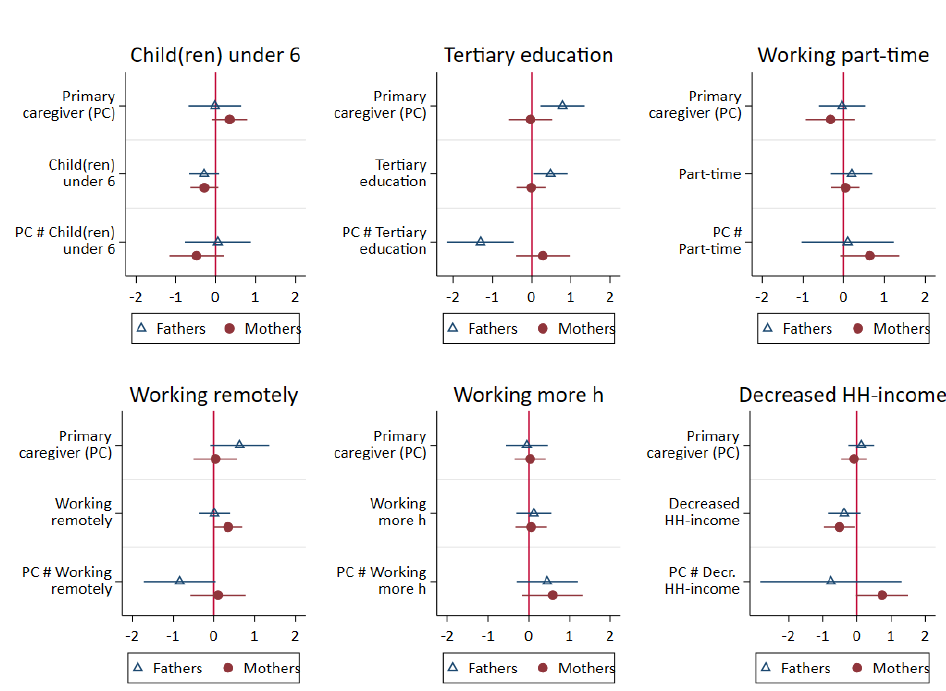
Figure 3: Interaction effects between mothers and fathers serving as primary caregivers and further